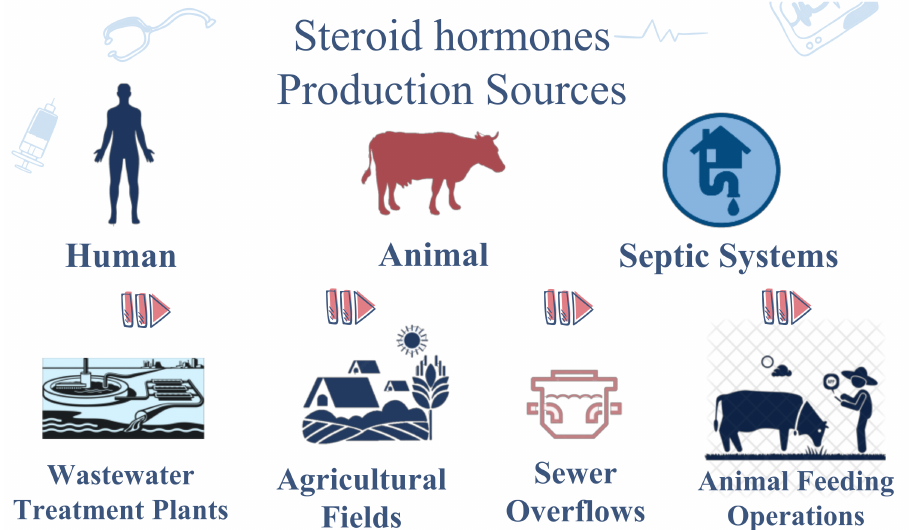
Figure 2. Steroid hormones’ various origins in nature, including human and animal sources, septic systems, concentrated animal feeding operations, combined sewer overflows, wastewater treatment plants, and agricultural